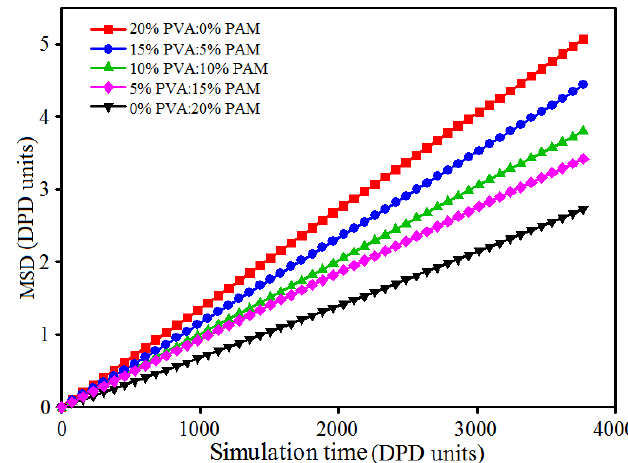
Figure 11. MSD (mean square displacement) curves of nano-silica beads in PVA/PAM/1.5% nano-silica blended hydrogels with different polymer component ratios.